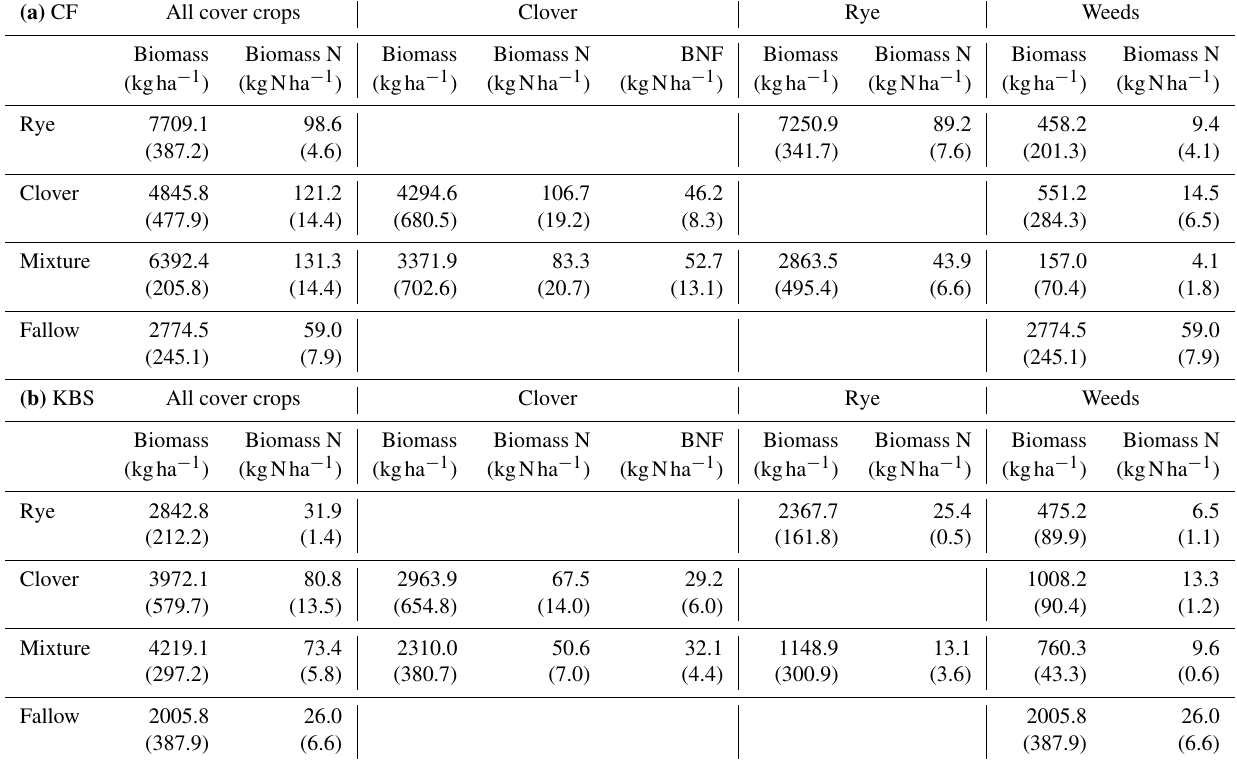
Table A1. Means (standard error) for aboveground biomass, biomass nitrogen, and biological nitrogen fixation (BNF) by species across treatments at CF (a) and KBS (b)